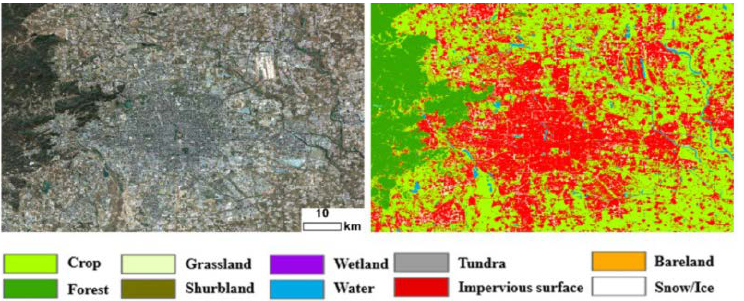
Figure 2. Example of multiclass image segmentation on a complex land cover area, left hand side, true color image from satellite, right hand side, classification using the classes in the legend, from Yao, et al. 2022 slightly modified.